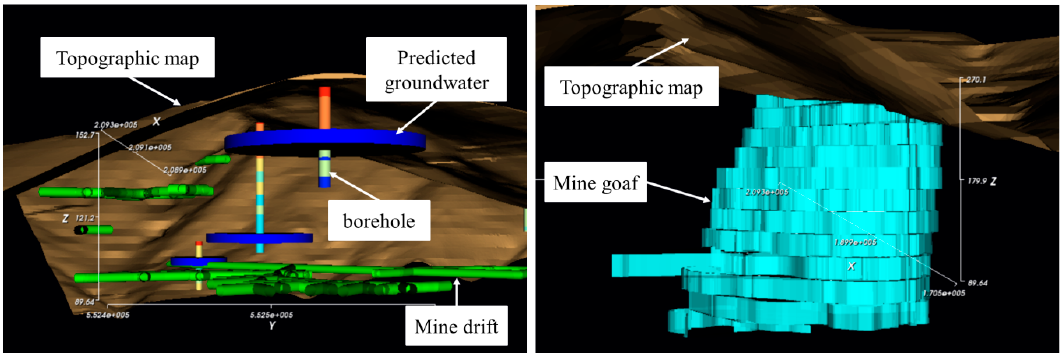
Figure 6. Examples of different 3D object data files.